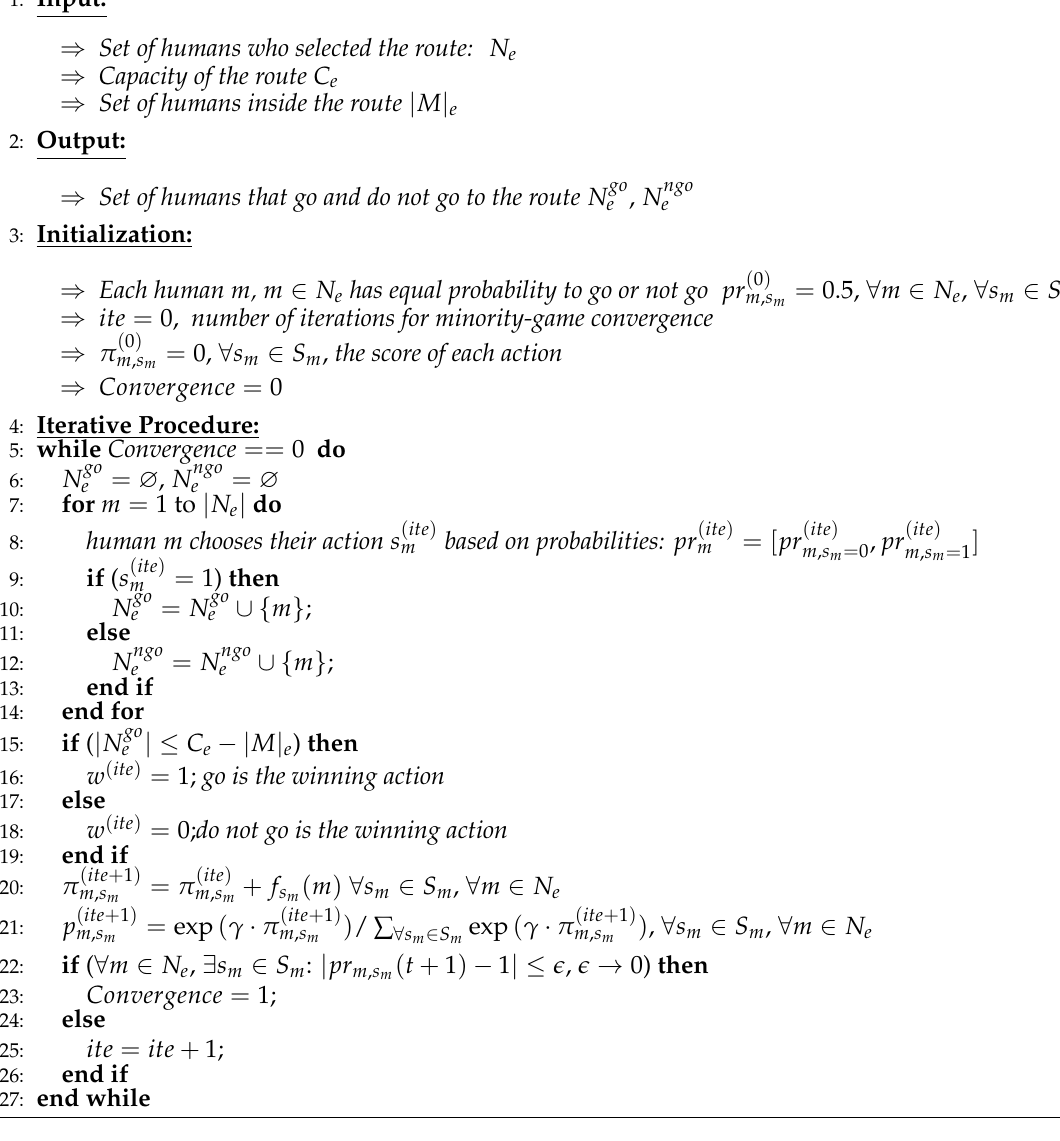
Algorithm 2 Distributed Exponential Learning Algorithm for Minority Games